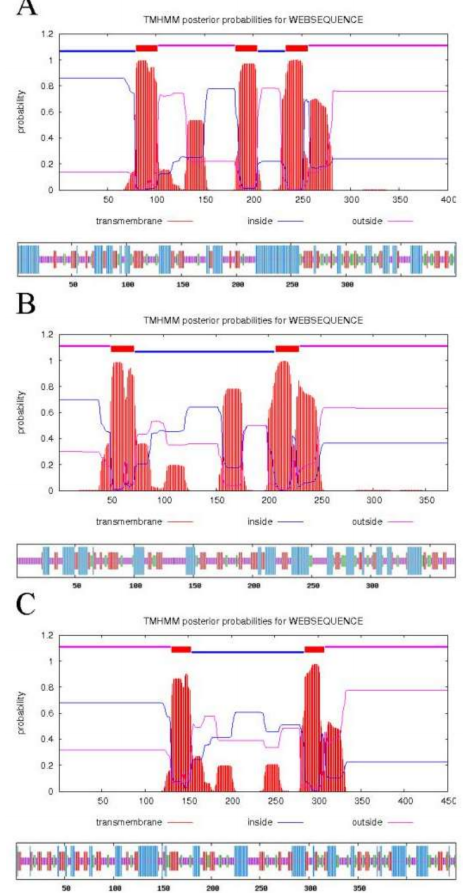
Figure 2. Transmembrane domain prediction and secondary structure prediction of PoFAD8-1 , PoFAD8-2 , and PoFAD8-3 . ( A ) Transmembrane domain prediction and secondary structure prediction of PoFAD8-1 . ( B ) Transmembrane domain prediction and secondary structure prediction of PoFAD8-2 . ( C ) Transmembrane domain prediction and secondary structure prediction of PoFAD8-3